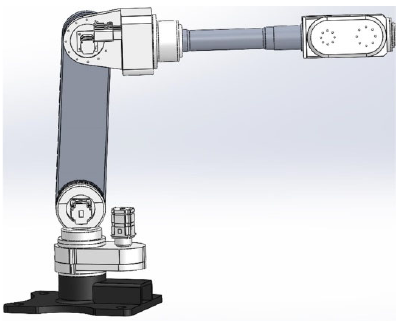
Figure 4. Structure of the mechanical arms.